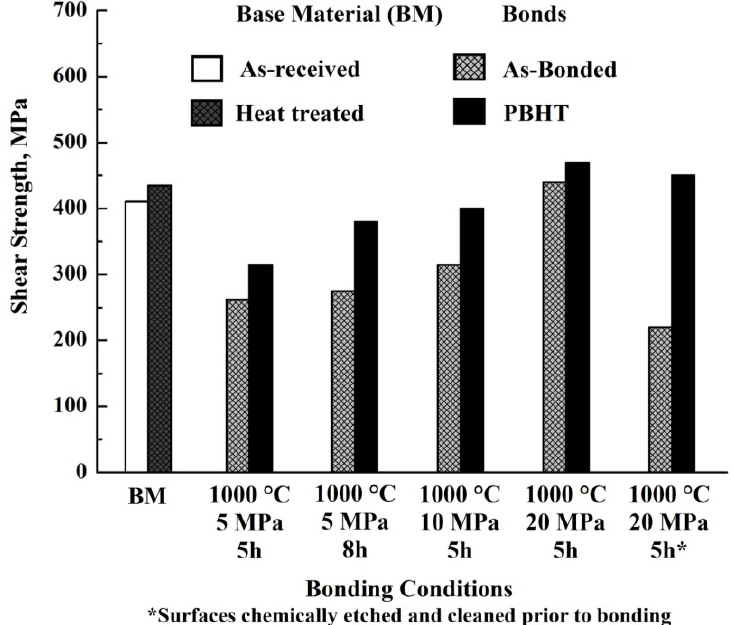
Figure 7. Results of compression overlap shear tests on γ-TiAl bonds in the as-bonded condition and after a post bond heat treatment (PBHT) at 1430 °C. Each strength value is average of at least four specimens. (Reprinted with permission from [11]. Copyright 1999,